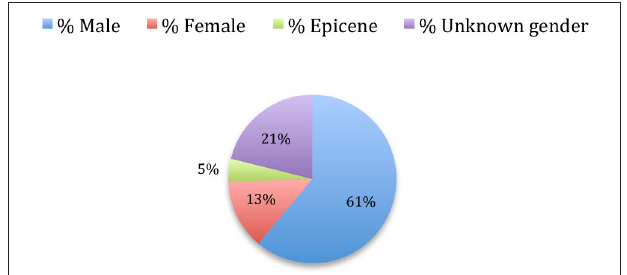
FIGURE 24 | Authorships’ gender.